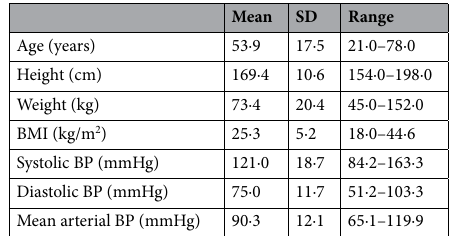
Table 3. Participants’ characteristics (n = 40) used to validate